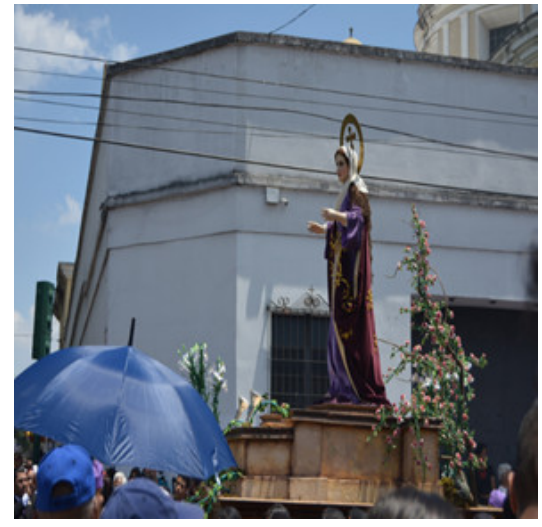
Figure 5. Image of Maria Magdalene of the Church of la Recolección. Photos: Karen Ponciano.